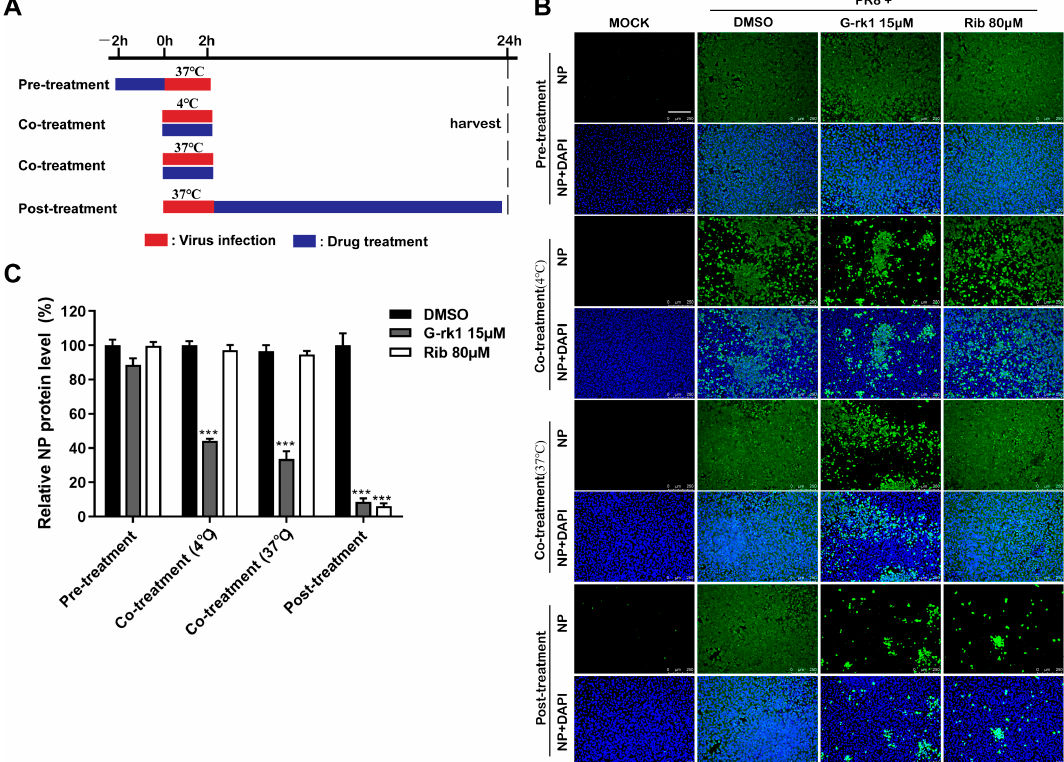
Figure 3. G-rk1 inhibits PR8 infection by targeting the virus entry. ( A ) Scheme for the time-course inhibition experiment. A549 cells were treated with 15 µM G-rk1 or 80 µM ribavirin for 2 h prior to PR8 (0.1 MOI) infection (pre-treatment) or incubated with G-rk1 or ribavirin during PR8 (0.1 MOI) infection at 4 °C or 37 °C for 2 h (co-treatment), or with G-rk1 or ribavirin for 24 h post-infection (0.1 MOI) (post-treatment). Paraformaldehyde was used to fix the cells, and IFA was used to show the viral NP expression at 24 hpi ( B , C ). Scale bar: 250 µm. Statistical significances are denoted by *** p < 0.001 compared to the DMSO control.